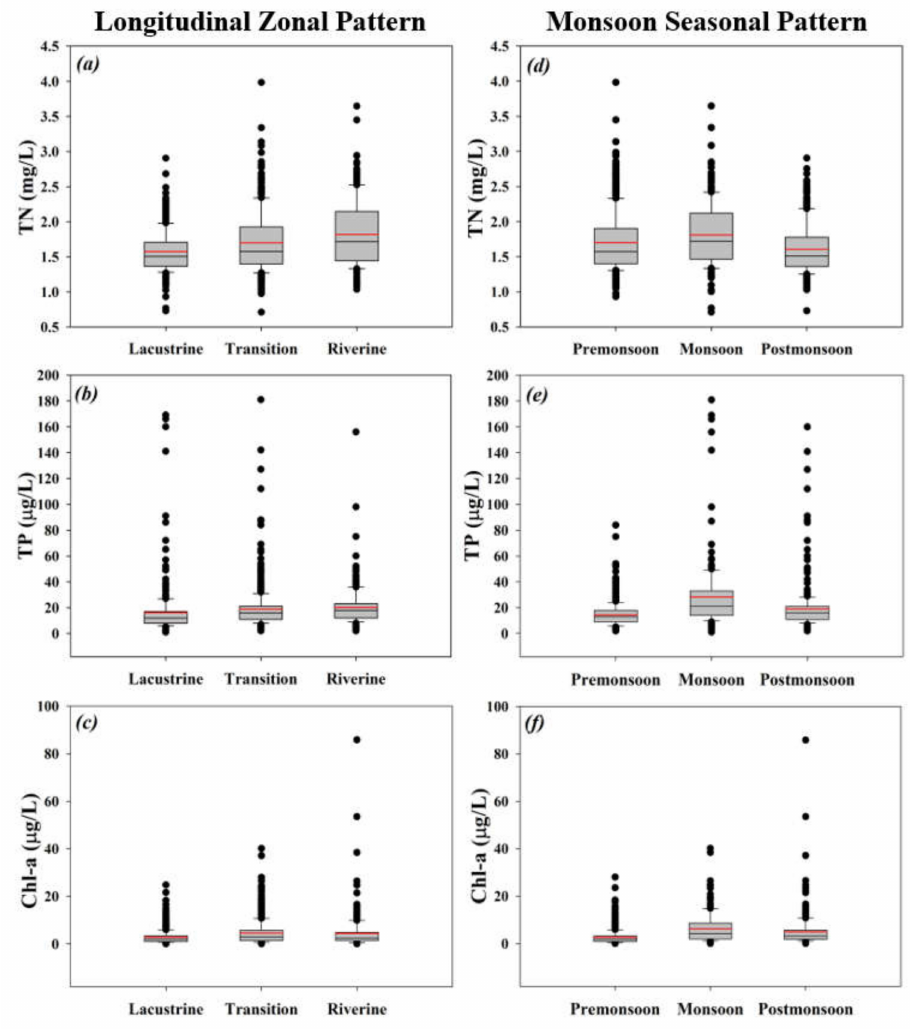
Figure 4. Comparisons between longitudinal zonal and seasonal monsoon patterns of TN, TP, and Chl-a in the Soyang reservoir during 1992–2013. Where ( a ), ( b ) and ( c ) show the longitudinal zonal patterns if TN, TP and Chl-a, respectively, while ( d ), ( e ) and ( f ) indicate the seasonal monsoon patterns of TN, TP and Chl-a,